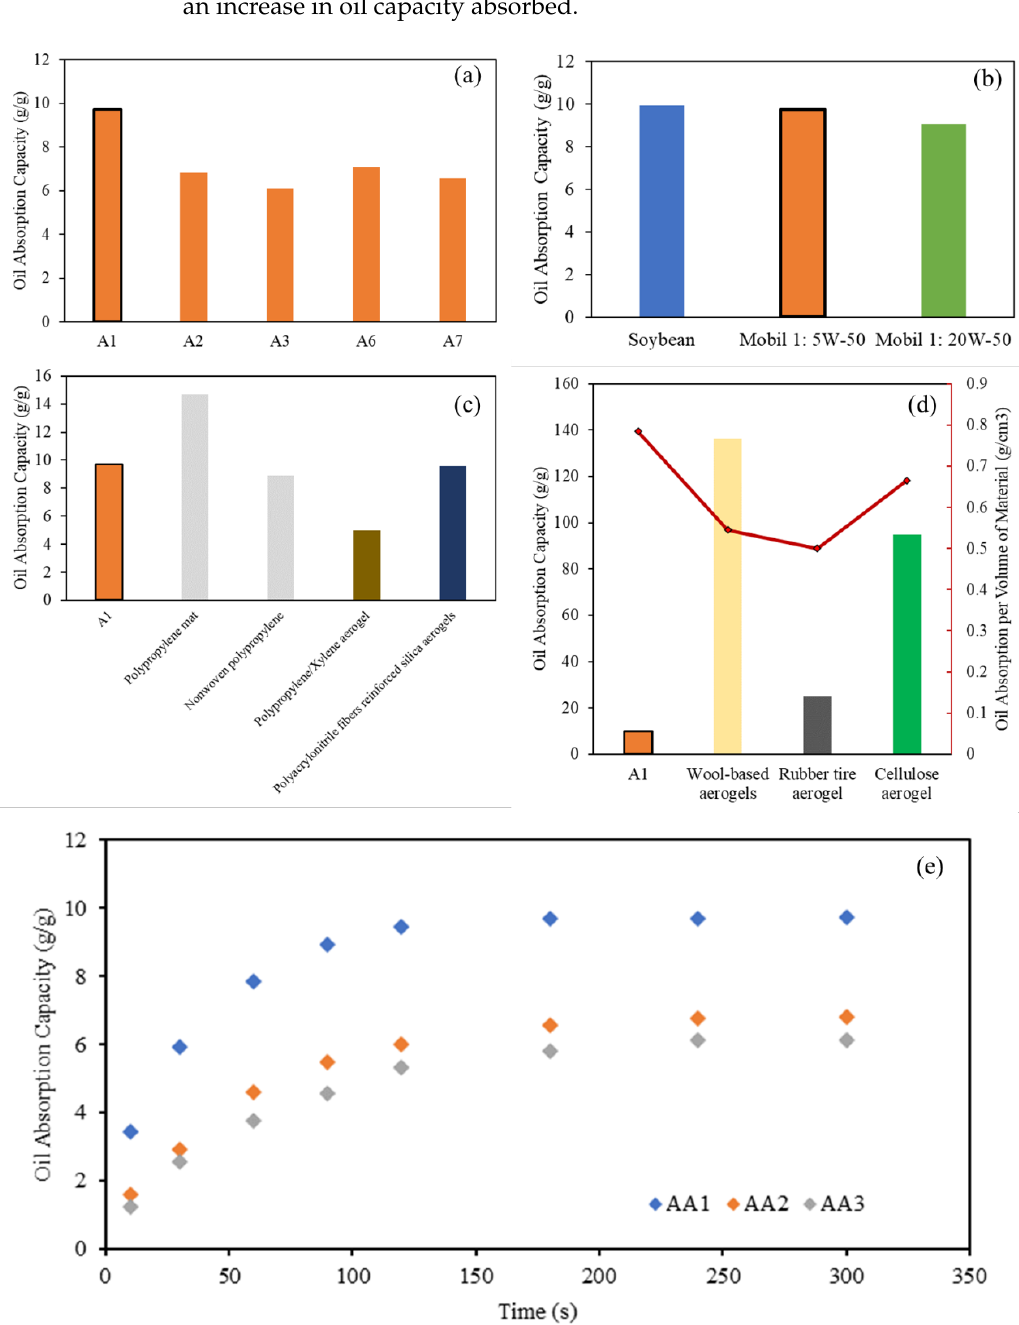
Figure 9. Oil absorption capacity of AAs with varying aluminum content (A1, A2, A3), and varying crosslinker concentration (A6, A2, A7) ( a ). Oil absorption capacity of A1 with different oil types ( b ). Comparison of oil absorption capacity with commercial materials and aerogels ( c ). Comparison of oil absorption of AAs per volume of material and their capacity ( d ). Absorption kinetics of the 5W-50 motor oil on AAs of varying aluminum content over 300 s ( e ). The absorption kinetics of 5W - 50 motor oil on AAs with varying aluminum content (4 – 8 wt.%) with a fixed crosslinker concentration (3 wt.%) was investigated and reflected upon in Table 1. The pseudo - first - order models and pseudo - second - order models are plot- ted using ln[Qm/(Qm − Qt)] and (t/Qt) against time, t, respectively. The pseudo - first - order model and pseudo - second - order model graphs of the respective AAs are illustrated in Figure 10a – c and b – d , respectively. The absorption rate coefficients, k 1 and k 2 , and the coefficient of determination, R 2 , as shown in Table 1, were calculated from the graph plots